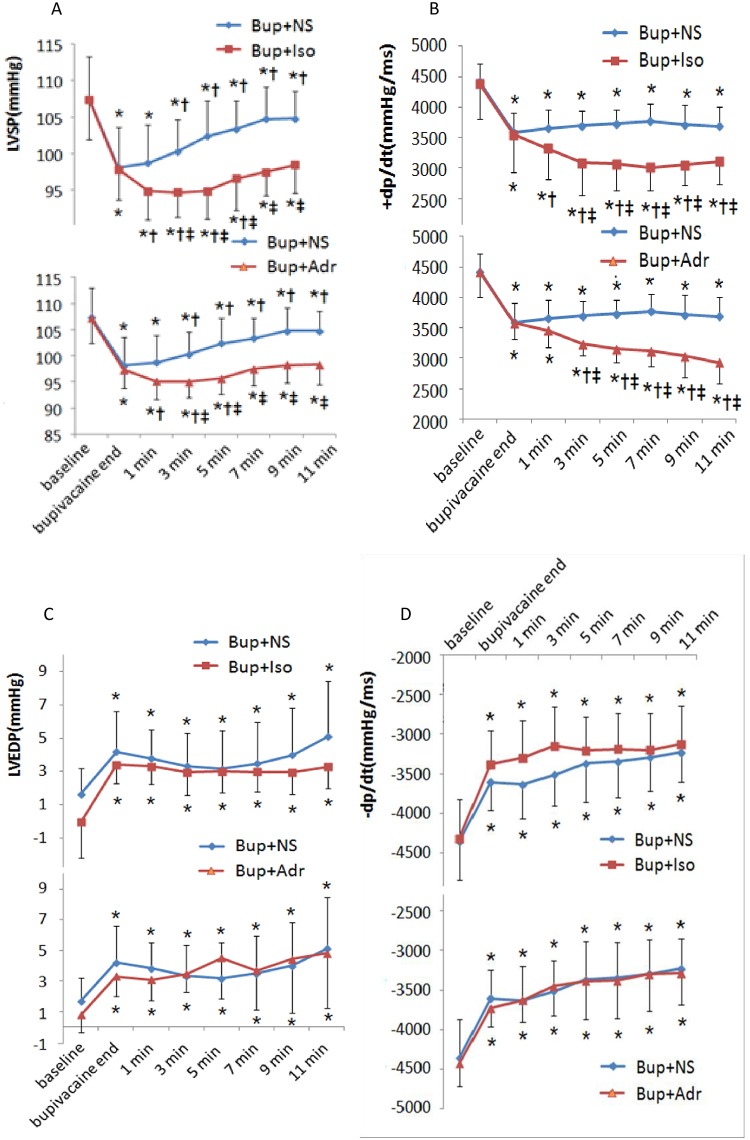
Inotropic effect of β-adrenergic agonists in bupivacaine-intoxicated rats.(A) and (B) Bupivacaine significantly reduced LVSP and +dp/ptmax, while isoprenalin and adrenalin induced a further reduction of LVSP and +dp/ptmax. (C) and (D) Bupivacaine significantly increased LVEDP and -dp/ptmax, while isoprenalin and adrenalin did not show a significant effect. *P < 0.05, vs. baseline; †P < 0.05, vs. bupivacaine end; ‡P < 0.05, vs. bupivacaine + NS group.